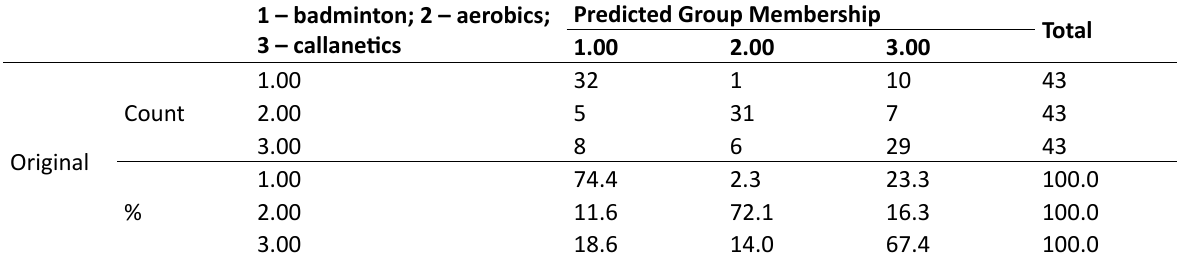
Fig. 2. Indicators of female students’ fitness depending on sports specialization: 1 – badminton; 2 – aerobics; 3 – callanetics Table 13. Classification